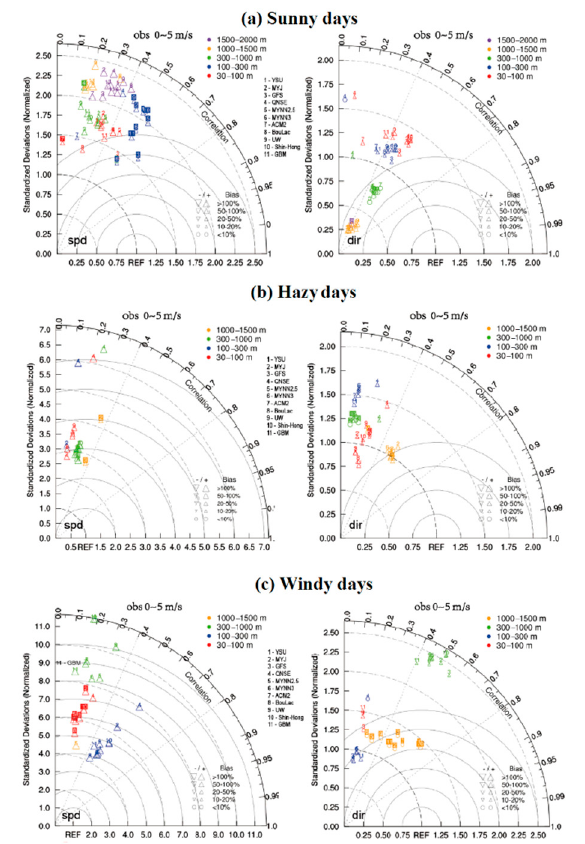
Figure 9. Taylor charts of mean bias, correlation coefficients and standard deviations for the model results with 11 PBL schemes. On ( a ) sunny days, ( b ) hazy days, and ( c ) windy days, with the observed wind speed at 0–5 m·s –1 .